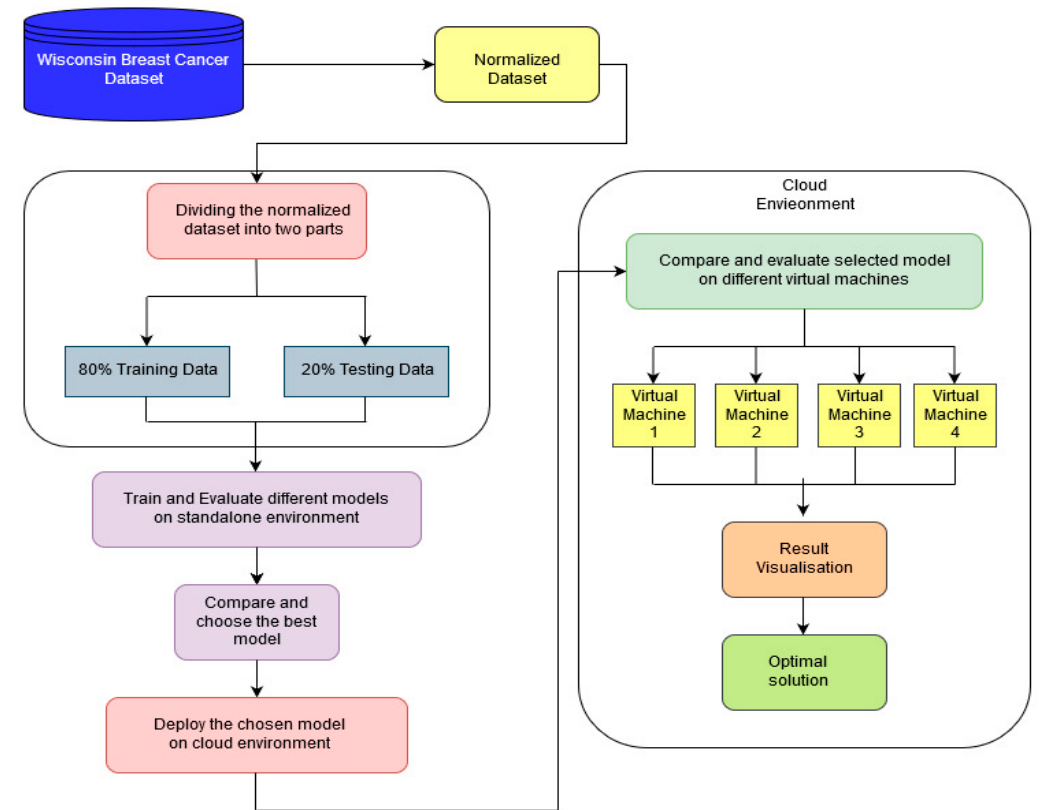
Figure 3. Experimental steps.